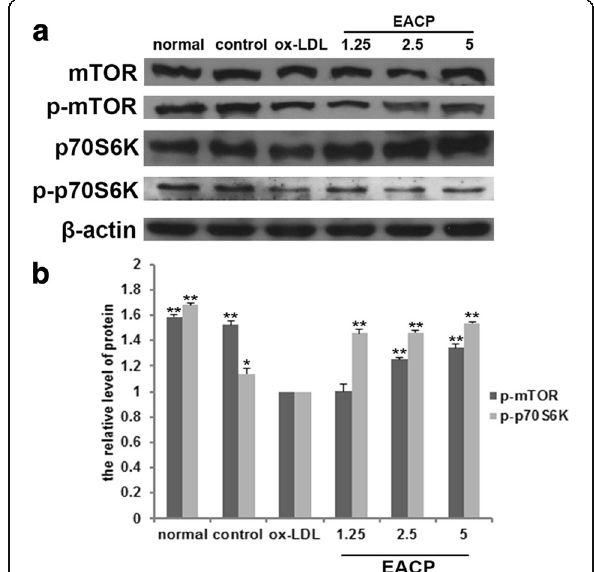
Fig. 4 EACP inhibited ox-LDL-decreased mTOR activity in HUVECs. a , Expression of mTOR, p-mTOR, p70S6K, p-p70S6K after treatment with EACP in ox-LDL induced HUVECs at 6 h; b , Quantification of relative expression quantity of p-mTOR and p-p70S6K in ox-LDL induced HUVECs at 6 h. ( * P < 0.05, ** P < 0.01 vs ox-LDL group, n = 3). Data are means ±